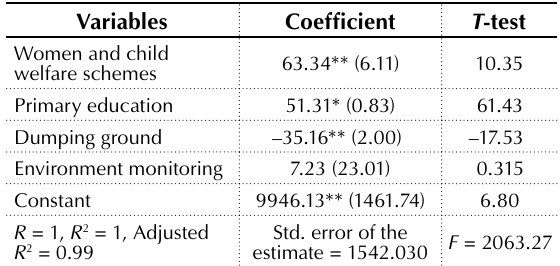
Table 9. Regression results for